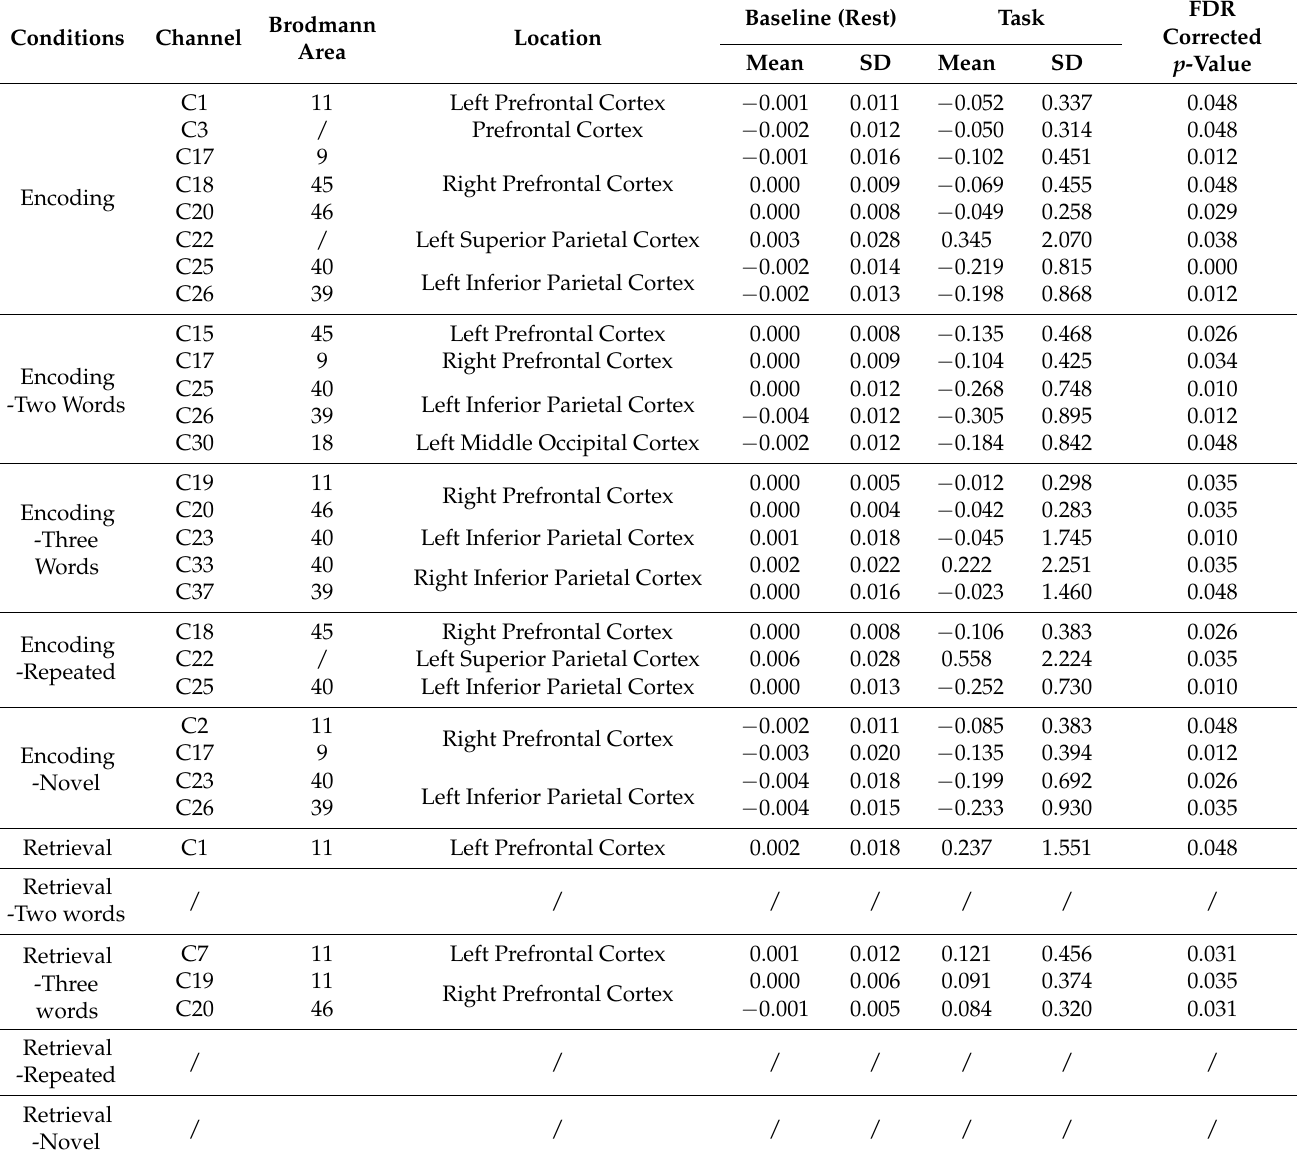
Table 1. The significance of HbO concentration in different conditions (i.e., baseline vs.